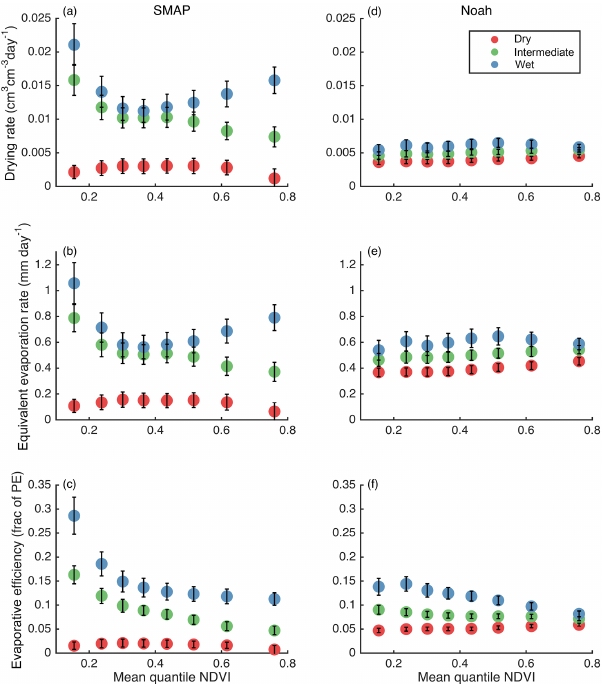
Figure 10. As in Fig. 7, but drying rates are divided among the four most prevalent soil texture classes. Markers are omitted if fewer than 0.05% of the total calculated drying rates fall within the VSM/soil texture